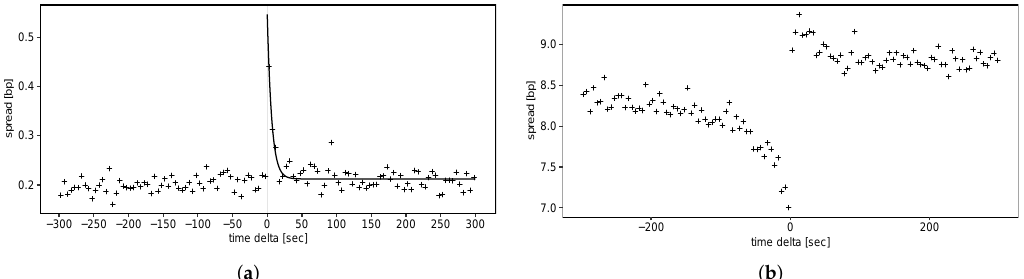
Figure A4. Resiliency of liquidity costs for the Coinbase BTC/USD market. The figures display three different average measures of liquidity cost in the event time τ of the 1 percent largest trades. ( a ) Evolution of the average bid-ask spread ¯ s ( τ ) . We include the fit of an exponential function with exponential time constant T ≈ 6.3s to guide the eye; ( b ) Evolution of the average volume-weighted average price spread ¯ vs ( ω , τ ) for a volume of ω = 10 5